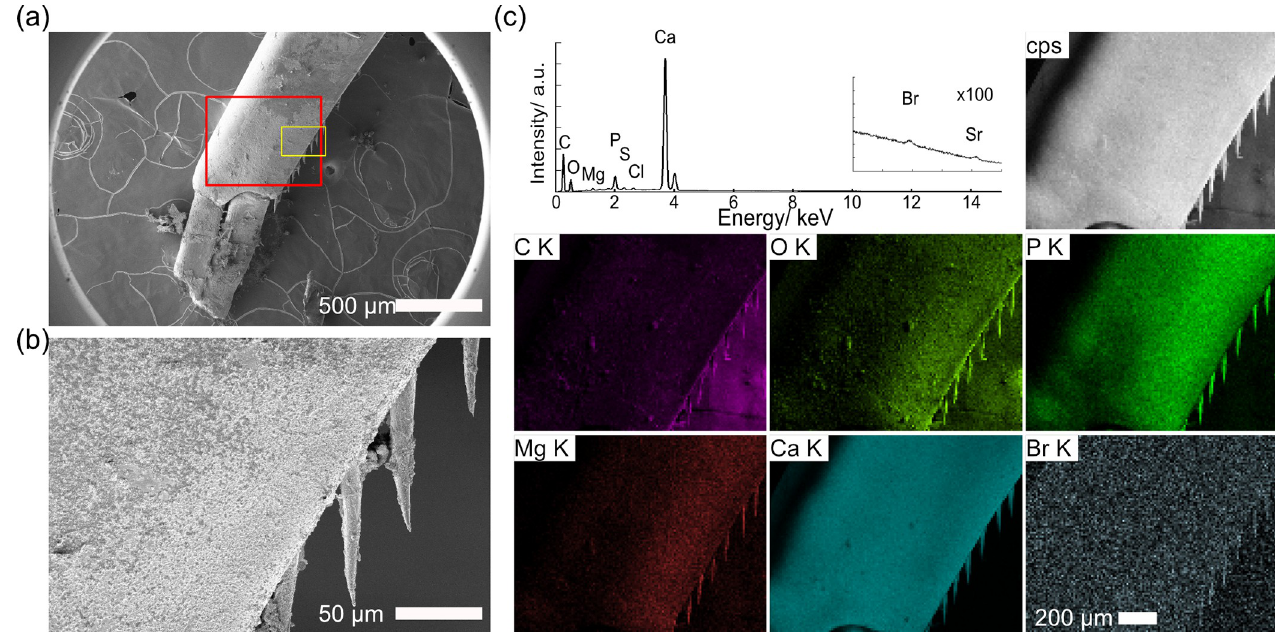
Fig 9. SEM images and EDS maps of an uropod of Hirondellea gigas . a) Low-magnification image. b) High-magnification image of the yellow square in (a). c) Sum spectrum and EDS maps of the red square in (a). The sum spectra at 10–15 kV were magnified and displayed in the inset above with the same energy scale for clarity.